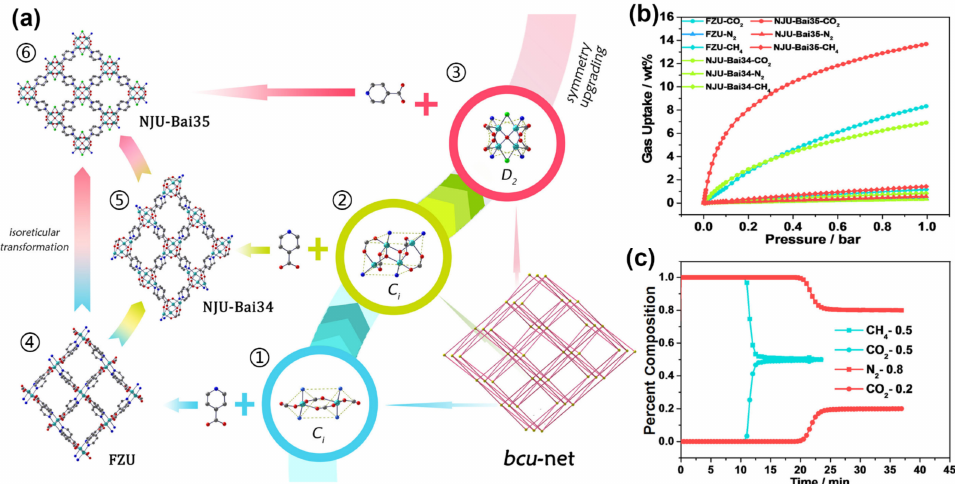
Figure 3. ( a ) Isoreticular transformation by symmetry-upgrading Cu clusters. Cu clusters and structures of FZU (1, 4), NJU-Bai34 (2, 5) and NJU-Bai35 (3, 6). ( b ) CO 2 adsorption isotherms measured at 298 K. ( c ) Breakthrough curves of NJU-Bai35 at 298 K. Reproduced with permission from Jiang et al., Journal of the American Chemical Society; published by American Chemical Society, 2018